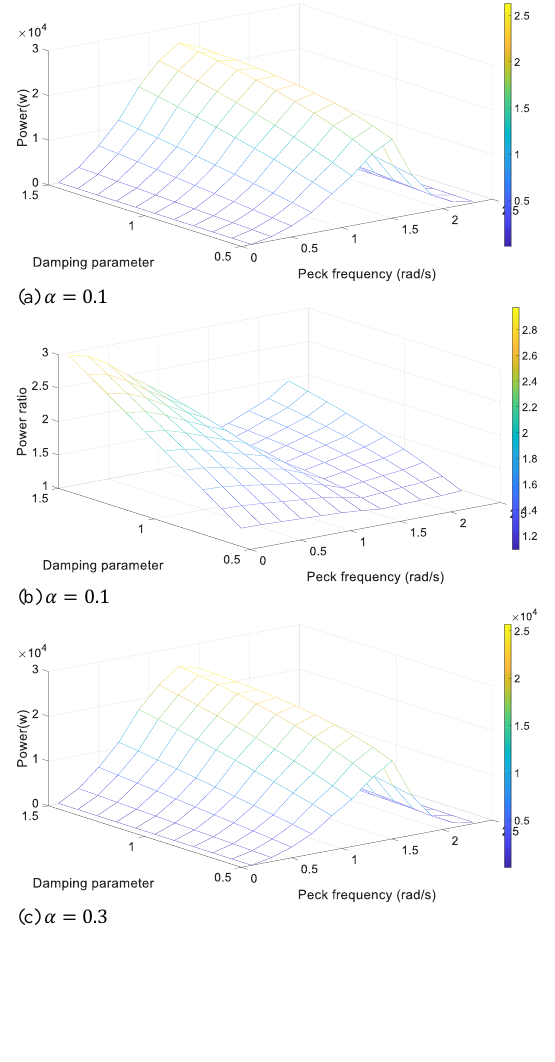
Fig. 7. The power and power ratio of WEC in different significant wave heights and nonlinear parameters with the different peak frequencies (a) (b) 𝜔 𝑚 = 0.3𝑟𝑎𝑑/𝑠 ; (c) (d) 𝜔 𝑚 = 1.3𝑟𝑎𝑑/𝑠 ; (e) (f) 𝜔 𝑚 =2.1𝑟𝑎𝑑/𝑠 . The value of damping parameter 𝛽 = 𝐶 is in range 𝐶 𝑜𝑝𝑡 [0.5, 1.5]. The effect of power of WEC is simulated with different damping parameters and peak frequencies in different nonlinear parameters. The results are shown in Figure 8. Though increasing the damping, the captured energy will increase. And the damping has a little effect to the peak frequency. However, the nonlinear parameter almost has nothing effect to the power ratio.